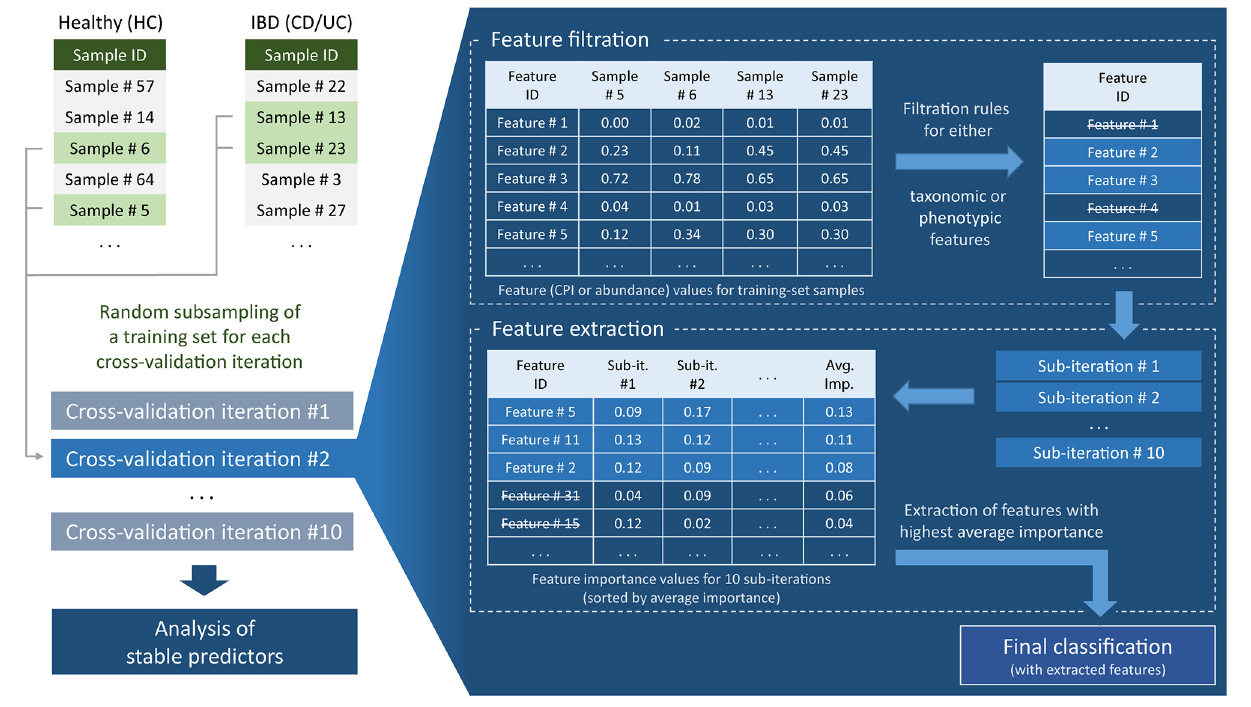
FIGURE 1 | Flowchart of machine learning approach for clinical status prediction based on microbiome data.